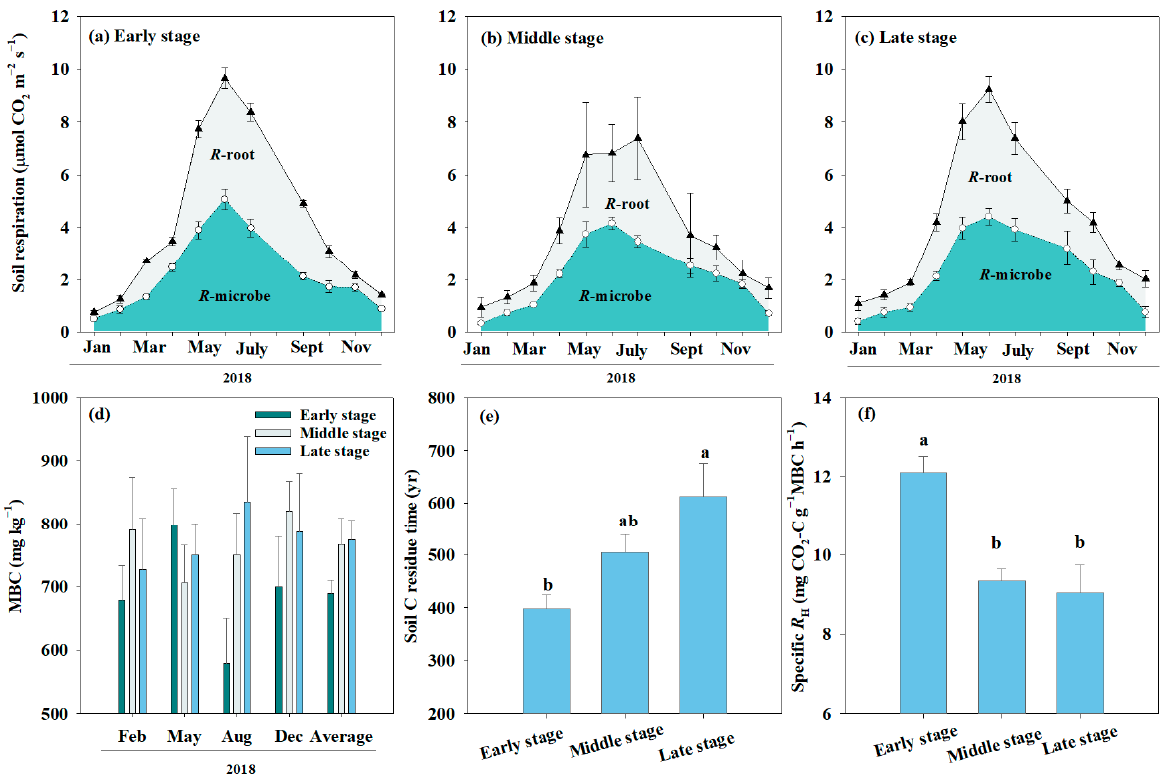
Figure 5. Soil respiration (panels ( a – c )), microbial biomass carbon (panel ( d )), specific microbial respiration (panel ( e )), and soil carbon residence time (panel ( f )) across three successional stages (Mean (SE). Closed circles and solid lines indicate soil CO 2 flux in Natural Control plots. Open circles and dashed lines denote soil CO 2 flux in root trenching plots. The area in green represents microbial respiration, whereas the area in light green represents root respiration. Abbreviations: MBC: microbial biomass carbon, R -root: root respiration, R -microbe: soil microbial respiration. Different lowercase letters indicate significant differences among successional stages, p < 0.05. Dots and bar charts represent mean values, vertical bars represent the standard error. Forests 2022 , 13 , x FOR PEER REVIEW